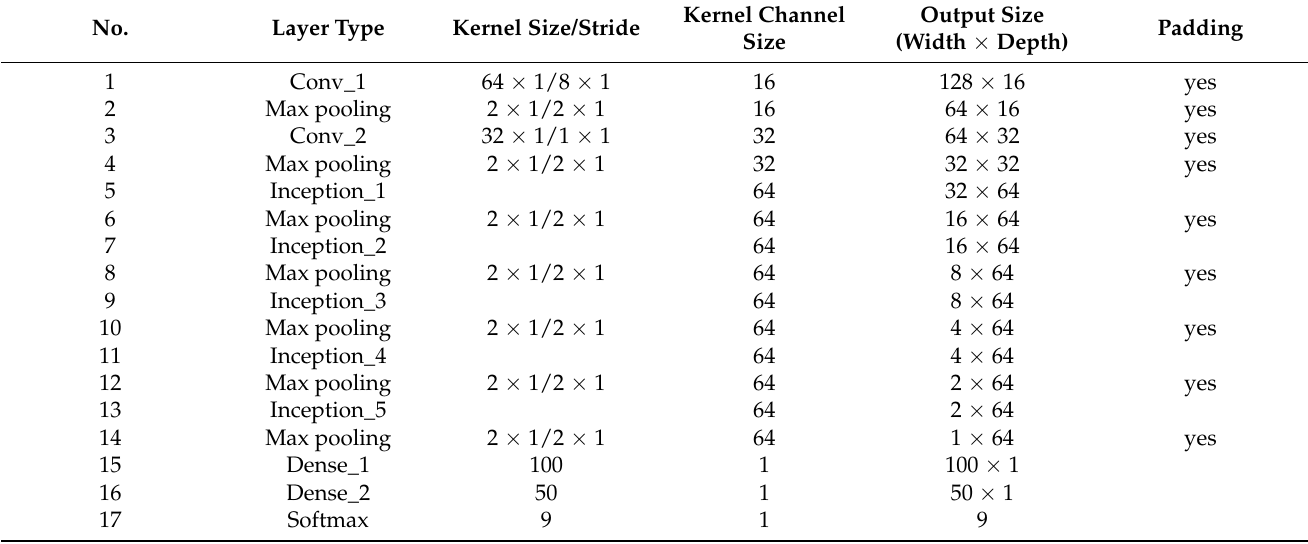
Table 3. Specific parameters of